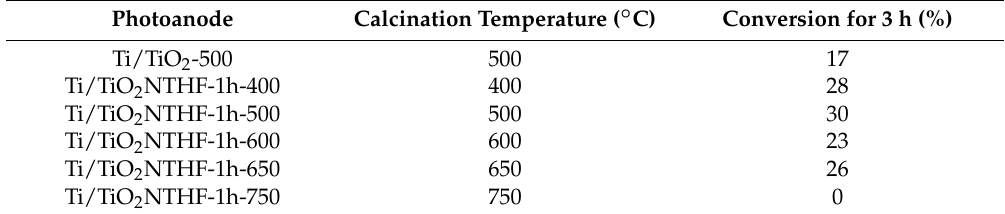
Table 3. PEC degradation results of paraquat by using Ti/TiO 2 -500 and Ti/TiO 2 NTHF-1h-Y electrodes. [paraquat]: 37.4 µ M, Applied potential vs. Ag/AgCl: 1.0 V.